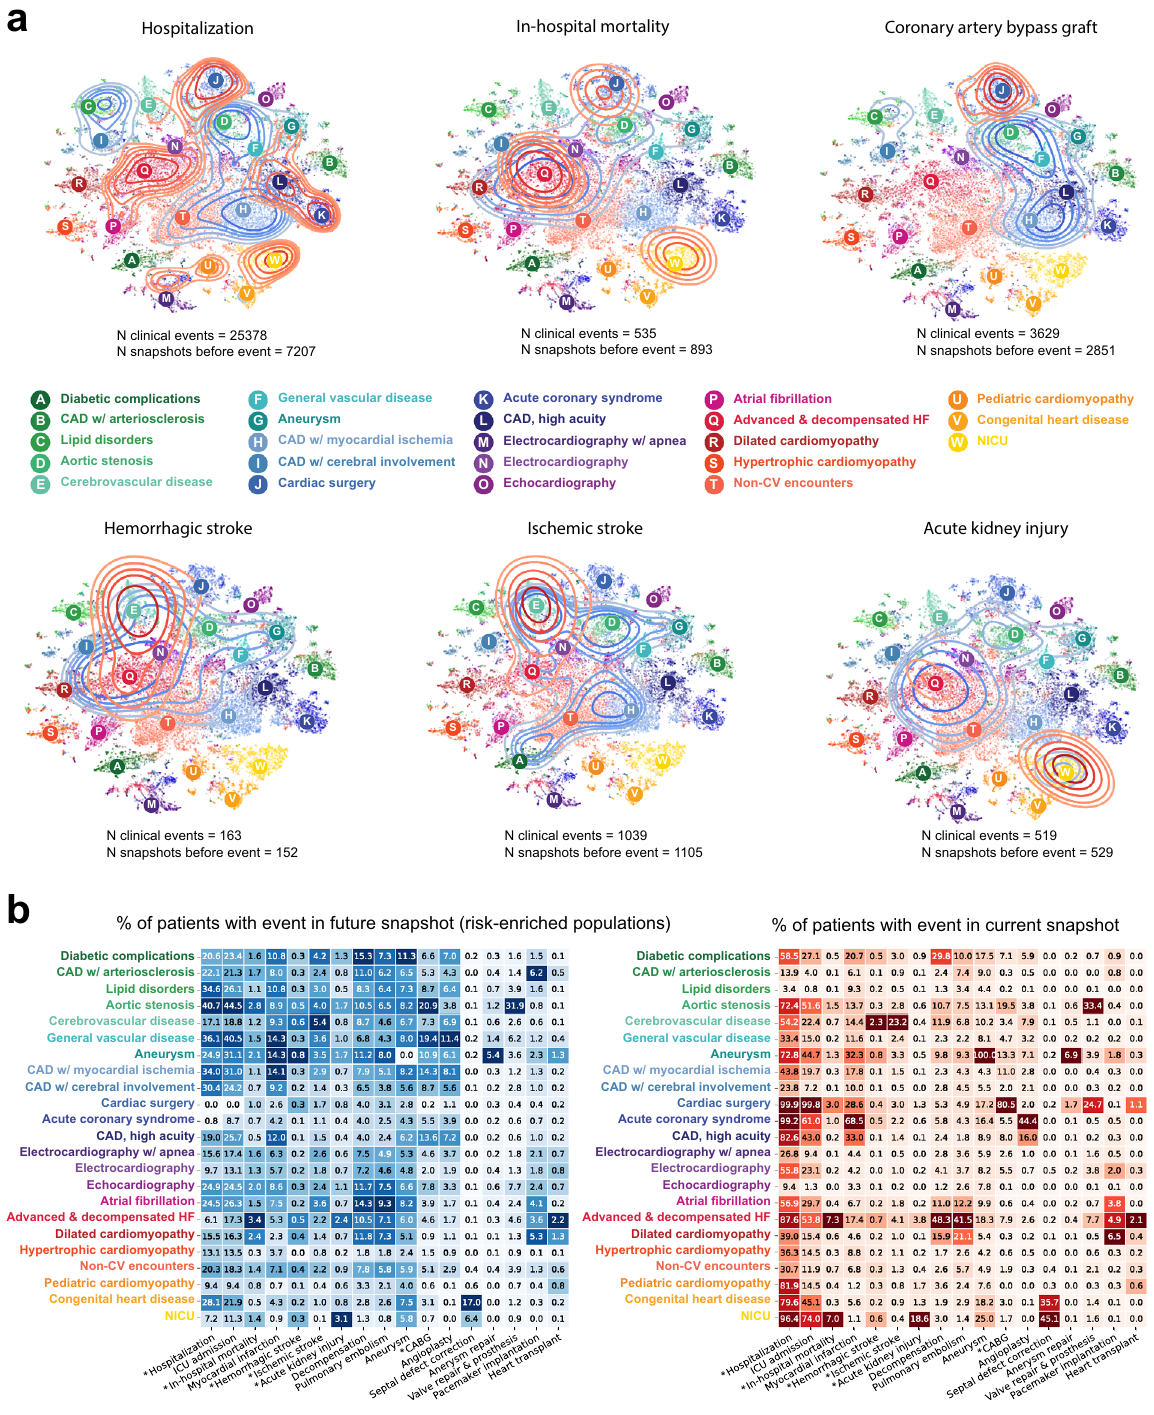
Figure 4. Current and future risk enrichment for clinical events in HF disease states. ( a ) Kernel density estimate of clinical events overlaid over HF disease states for six events: hospitalization, in-hospital mortality, and coronary artery bypass graft, hemorrhagic stroke, ischemic stroke, and acute kidney injury. Red density shows the density of snapshots in which the clinical event occurs (N clinical events). Blue density shows the density of snapshots before the first occurrence of the event (N snapshots before event). ( b ) Prevalence of clinical events (%) for the patient population in each disease state cluster in ( a